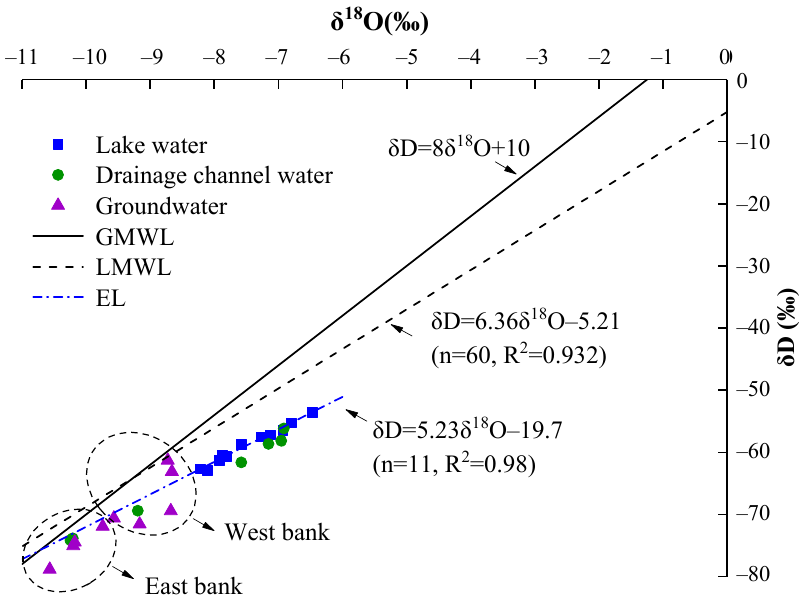
Figure 8. Comparison of the deuterium and 18 O ratios of water molecules in the three water bodies. GMWL: the global meteoric water line [42]. LMWL: the local meteoric water line (data from the Baotou Station of the Global Network of Isotopes in Precipitation collected from 1986 to 1993). EL: the lake water evaporation line (data from the lake water samples in this study).